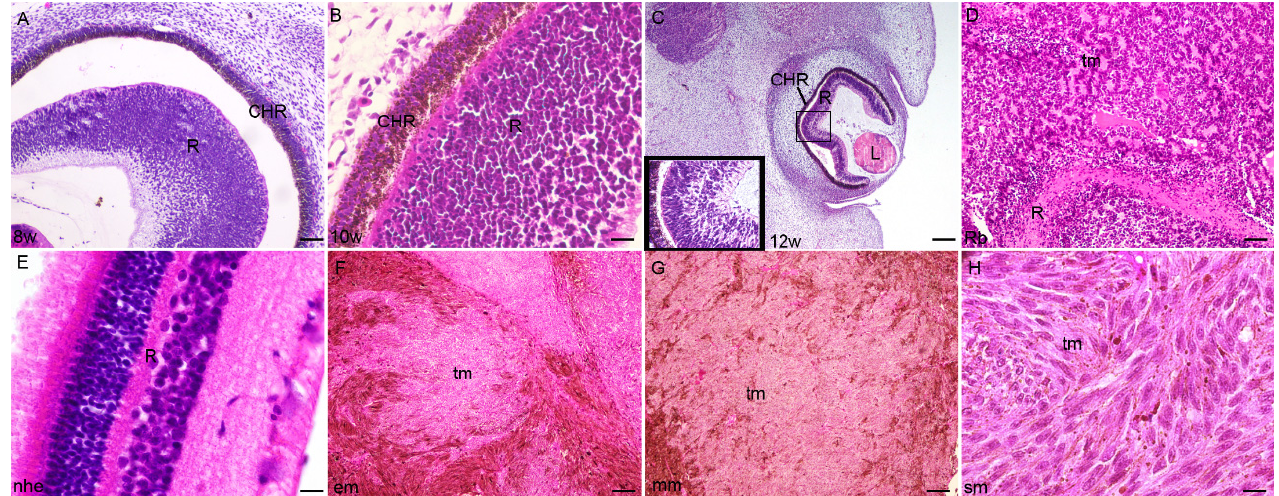
Figure 1. Section through the eye of an 8th-week (8 w) ( A ), 10th-week (10 w) ( B ), and 12th week (12 w) ( C ) human embryo, retinoblastoma (Rb) ( D ), normal human eye (nhe) ( E ), epitheloid melanoma (em) ( F ), mixoid melanoma (mm) ( G ) and spindle melanoma (sm) ( H ); R—retina, CHR—choroidea, tm—tumor tissue, L—lens. Hematoxylin and Eosin staining, Scale bar for ( A , D ) = 50 μ m, ( B ) = 25 μ m, ( E ) = 10 μ m, ( C , F – H ) = 100 μ m.